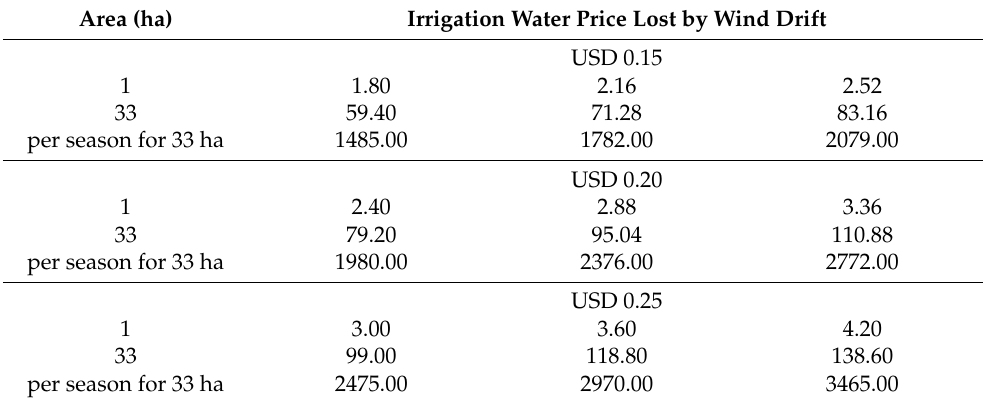
Table 6. Irrigation water price lost by wind drift during an irrigation event in center pivot irrigation affected by climate change.